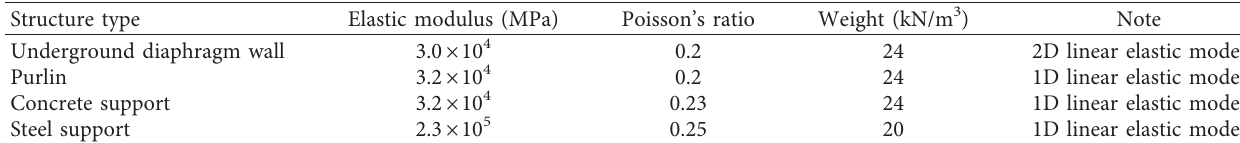
Table 2: Constitutive parameter of the supporting structure.